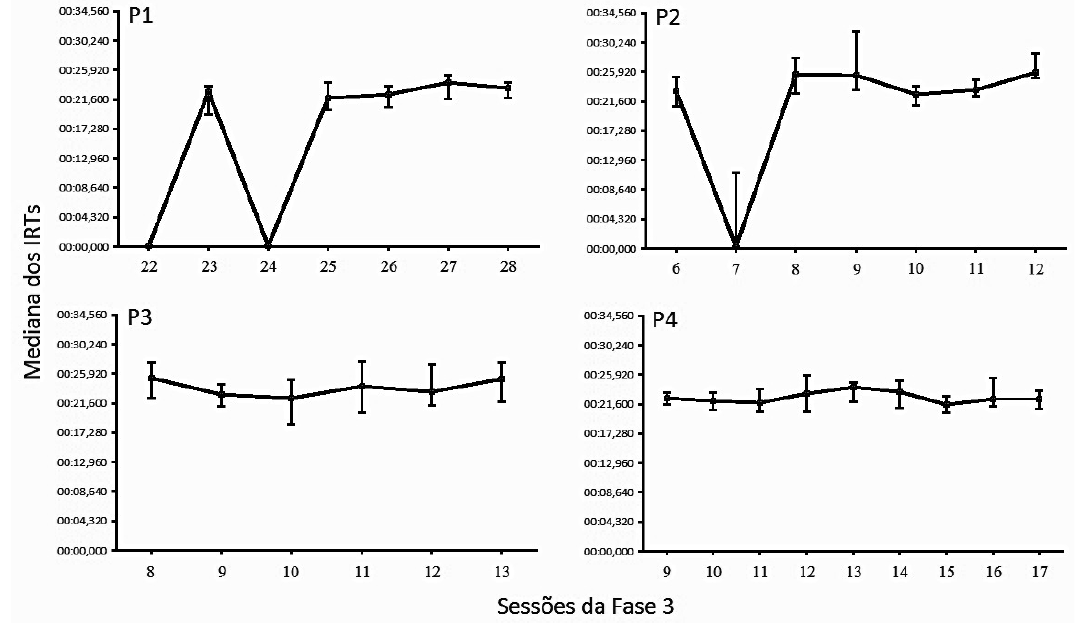
Figura 6 . Medianas dos IRTs (em segundos e milissegundos), do componente DRL para cada participante em todas as sessões